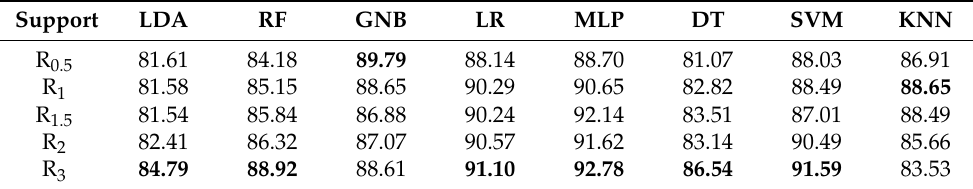
Table 4. The overall accuracy of the methods in Dublin City Area 2. The highest-obtained accuracies are shown as bold.